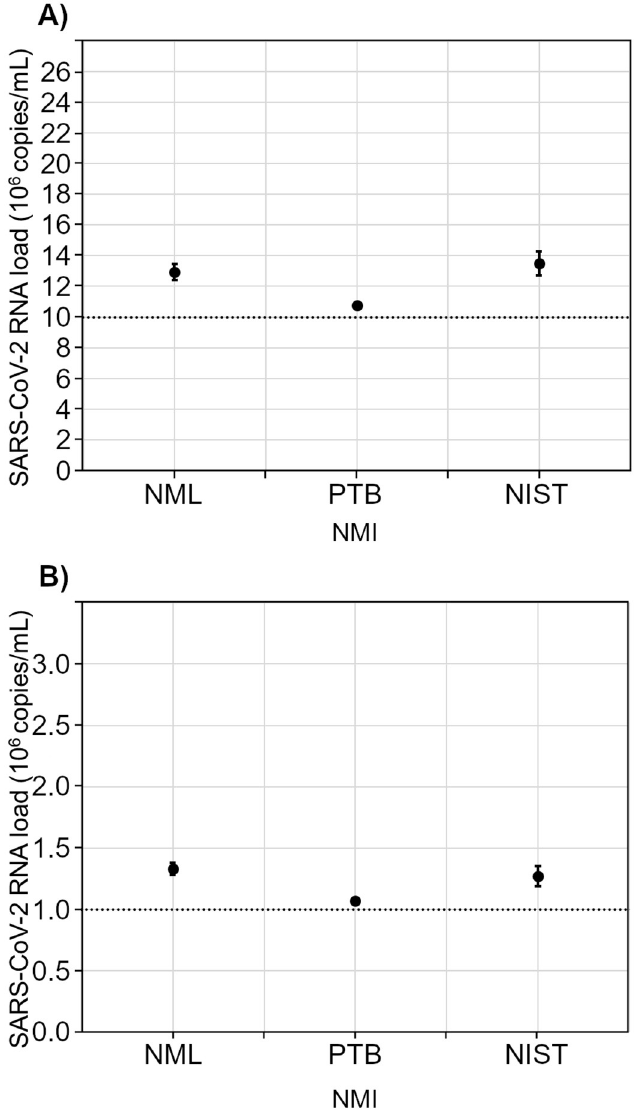
Fig 2. Digital PCR measurement results with 95% confidence intervals from three NMIs for RM 1 (A) and RM 2 (B). The dotted line in (A) represents the expected SARS-CoV-2 RNA loads of 10 7 copies/mL for RM 1. The dotted line in (B) represents the expected SARS-CoV-2 RNA loads of 10 6 copies/mL for RM